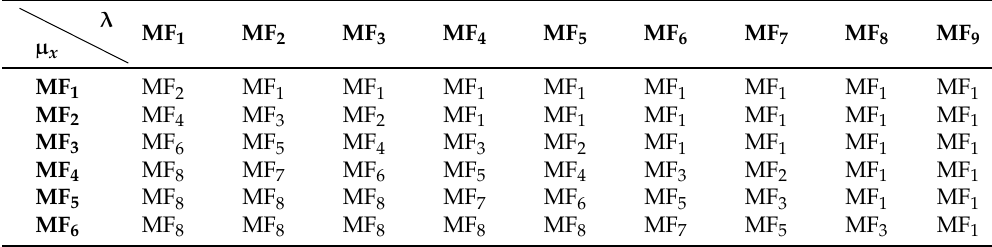
Table 3. Fuzzy linguistic rules for the ABS control.